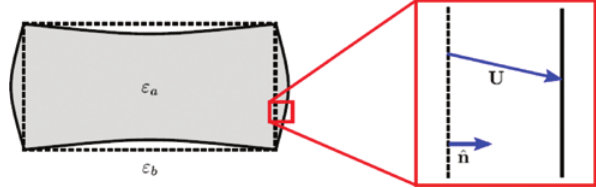
Figure 5: Illustration of the influence of boundary